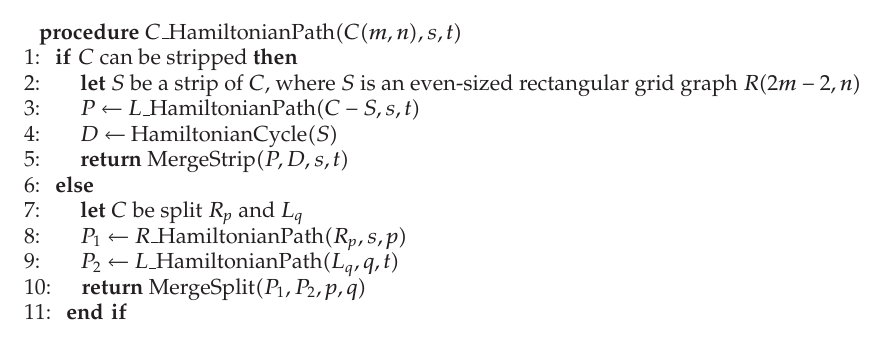
Algorithm 2: The Hamiltonian path algorithm for C -alphabet grid graphs.